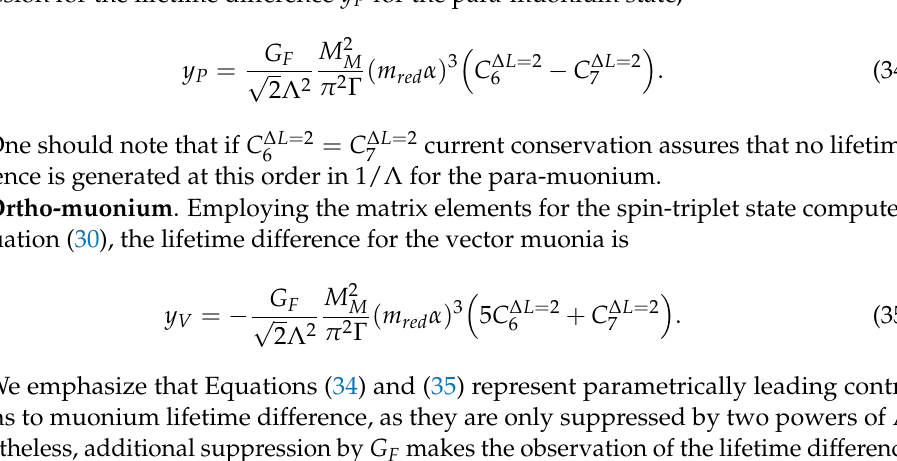
Figure 1. A diagram, whose imaginary part, denoted by the dotted line, represents the lifetime difference y . A white square represents a H Equation